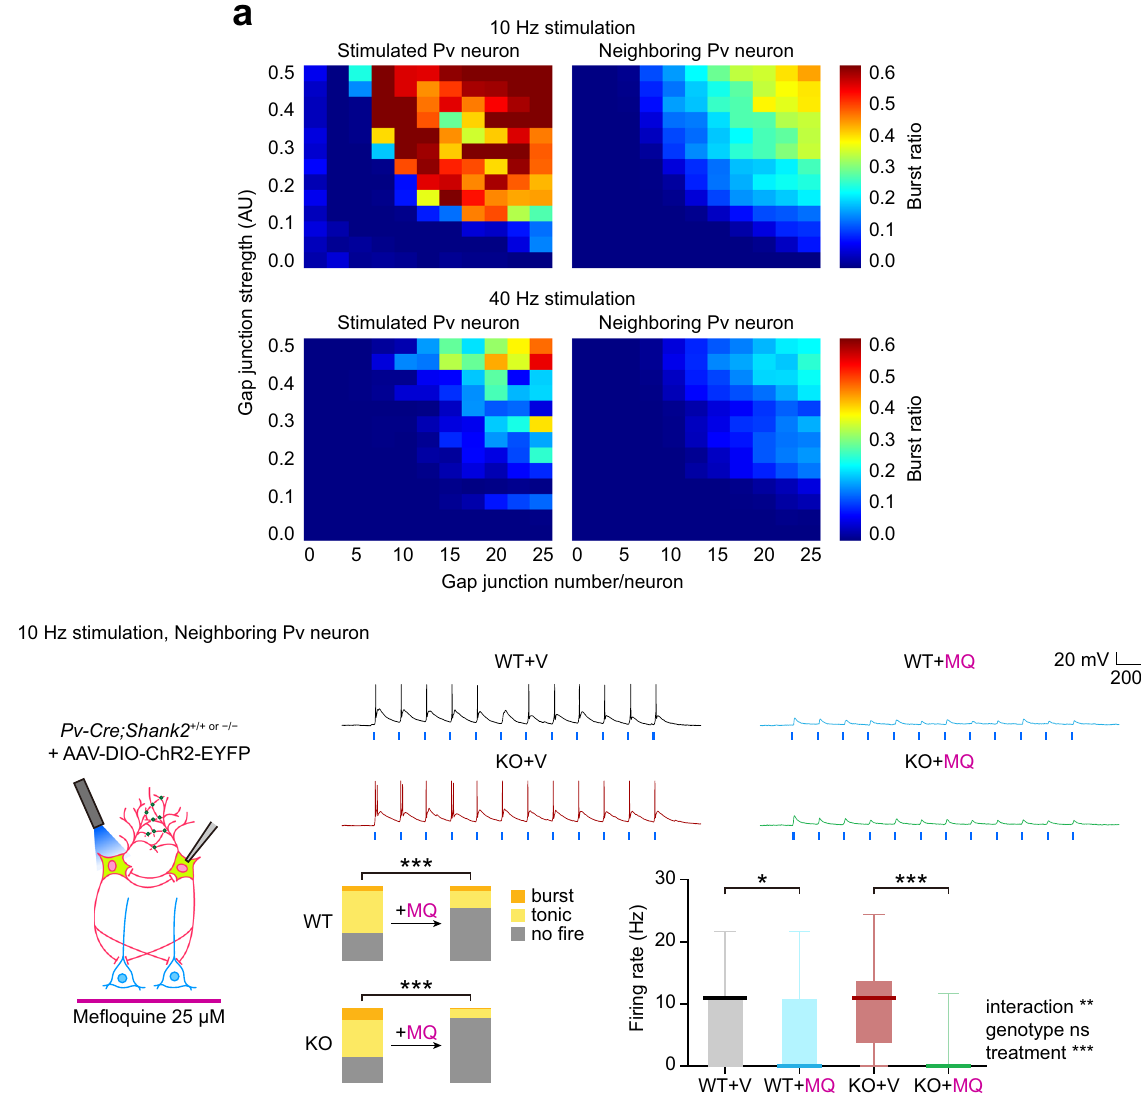
Fig. 6 Gap junction-dependent burst fi ring in Shank2 – / – Pv neurons. a Computational model simulations demonstrate that the number and the strength of individual gap junctions of a Pv neuron are positively correlated with the extents of Pv neuronal burst fi rings, as monitored in light-stimulated single Pv neurons or in Pv neurons neighboring a light-stimulated single Pv neuron. Note that 40-Hz stimulation is less effective than 10-Hz stimulation for inducing burst fi rings, probably due to the low-pass fi ltering characteristics of gap junctions. b Me fl oquine (25 µ M) treatment decreases burst and tonic fi rings and fi ring rates in Shank2 – / – Pv neurons neighboring a light-stimulated single Pv neuron, whereas it minimally affects burst fi ring in WT Pv neurons, although tonic fi ring and fi ring rate are decreased (prelimbic, layer 2/3, 12 – 13 weeks). Data: minimal, maximal, median, 25%, and 75% values ( n = 40 neurons from 13 mice [KO-V/vehicle, before me fl oquine/MQ treatment; KO-MQ/me fl oquine, after MQ treatment] and 29 neurons from 13 mice [WT-V and WT-MQ], * p < 0.05, *** p < 0.001, ns, not signi fi cant, Chi-square test [proportion], two-way ANOVA with Sidak ’ s test [ fi ring rate]; p < 0.0001 [WT-proportion], p < 0.0001 [KO-proportion], interaction p 0.0051, drug p < 0.0001, group p 0.8354 [ fi ring rate], WT p = 0.0105, KO p < 0.0001 [Veh-Mef, fi ring rate]). See Source data for raw data values and Supplementary Table 1 for statistical